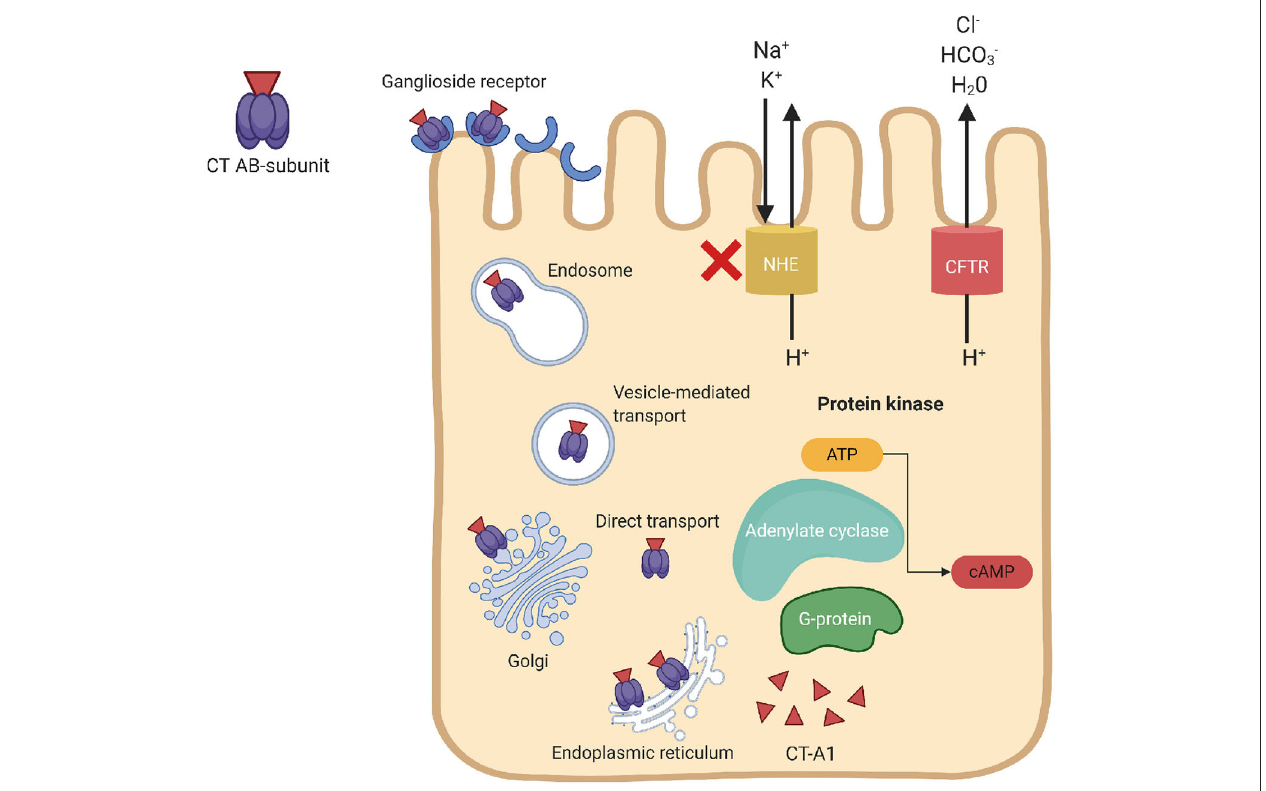
FIGURE 1 | Mechanism of action of the cholera toxin. CT binds to the ganglioside receptor on the host epithelial cells, triggers endocytosis of the holotoxin. The internalized CT moves from the endosomes to the Golgi complex and endoplasmic reticulum (ER). The catalytic CT-A1 polypeptide transfers from the ER to the cytosol by retro-translocation through the action of the ER-linked degradation pathway to activate the Gs α subunit of guanine nucleotide-binding regulatory (G α s ) protein. Activation of G α s -protein leads to increased adenylate cyclase (AC) activity, which cleaves ATP to cyclic adenosine monophosphate (cAMP) and subsequently activates protein kinase-A (PKA). Activation of PKA inhibits NaCl absorption through Na + /H + exchanger (NHE transporters) and phosphorylate the cystic fibrosis transmembrane conductance regulator (CFTR) chloride channel proteins, which leads to ATP-mediated efflux of chloride ions and induce secretion of HCO − 3 , Na + , K + , and H 2 O. Loss of chloride ions induces massive fluid secretion in the small intestine, deposing the resorptive ability of the large intestine, which results in severe watery diarrhea.